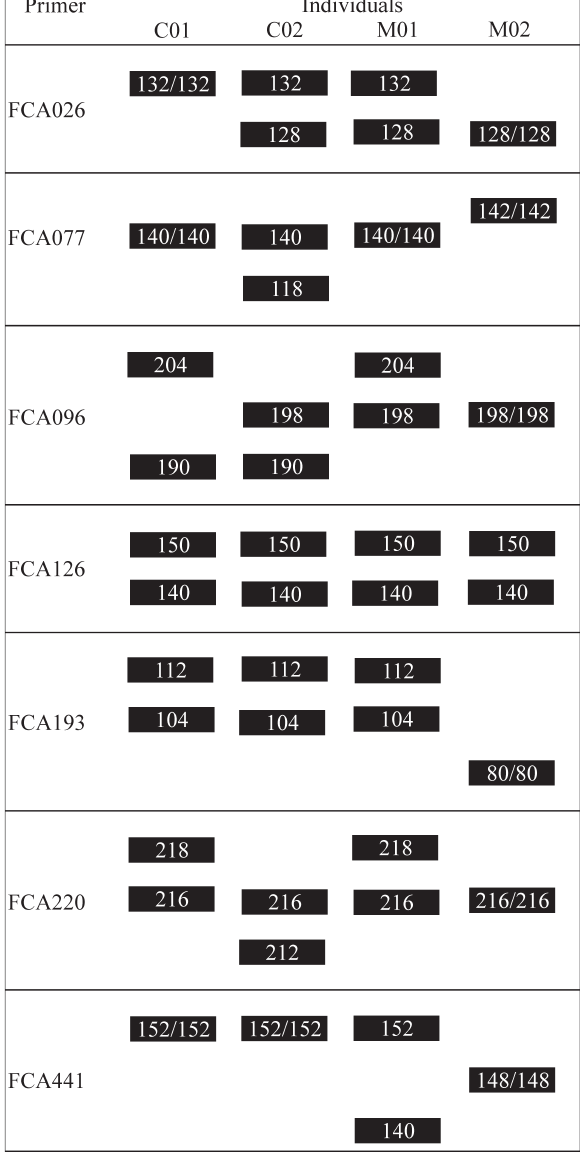
Figure 1 - Genotypes of four jaguars ( Panthera onca ) obtained using the FCA026, FCA077, FCA096, FCA126, FCA193, FCA220 e FCA441